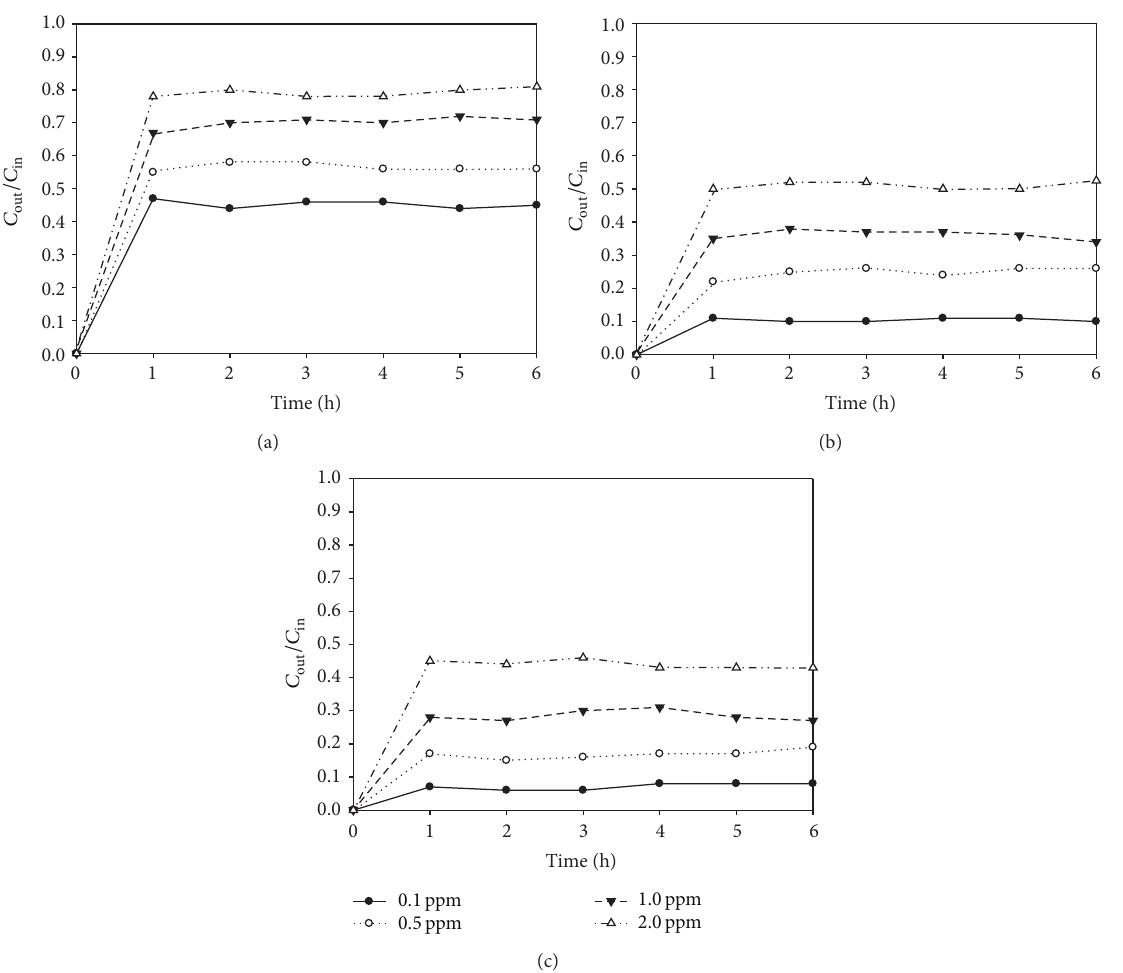
/𝐶 Figure 8: Time-series ratios ( 𝐶 ) of outlet-to-inlet concentrations of (a) toluene, (b) ethyl benzene, and (c) o-xylene as obtained using out in GF-N-TiO 2 -0.08 according to inlet